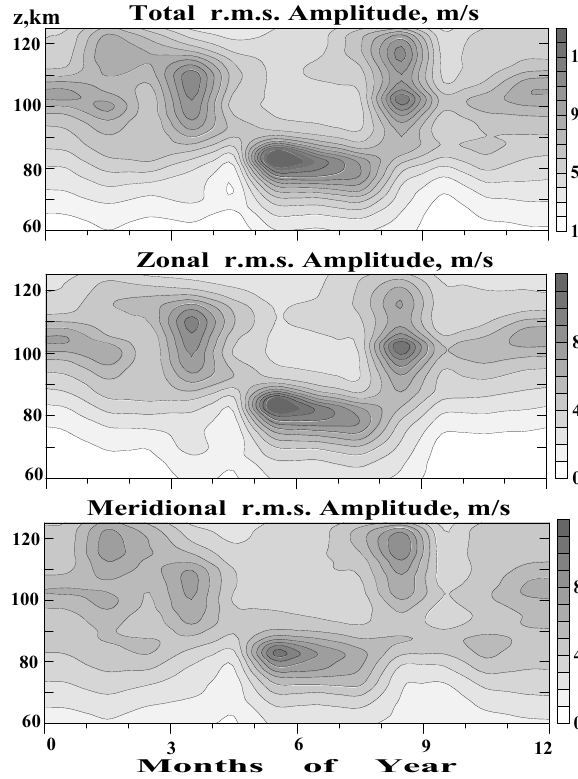
Fig. 4. Vertical-seasonal distributions of the mean zonal (top), Fig. 4. “Gavrilov and Jacobi, A study of seasonal…” meridional (middle) wind components and the strength of wave sources (bottom).